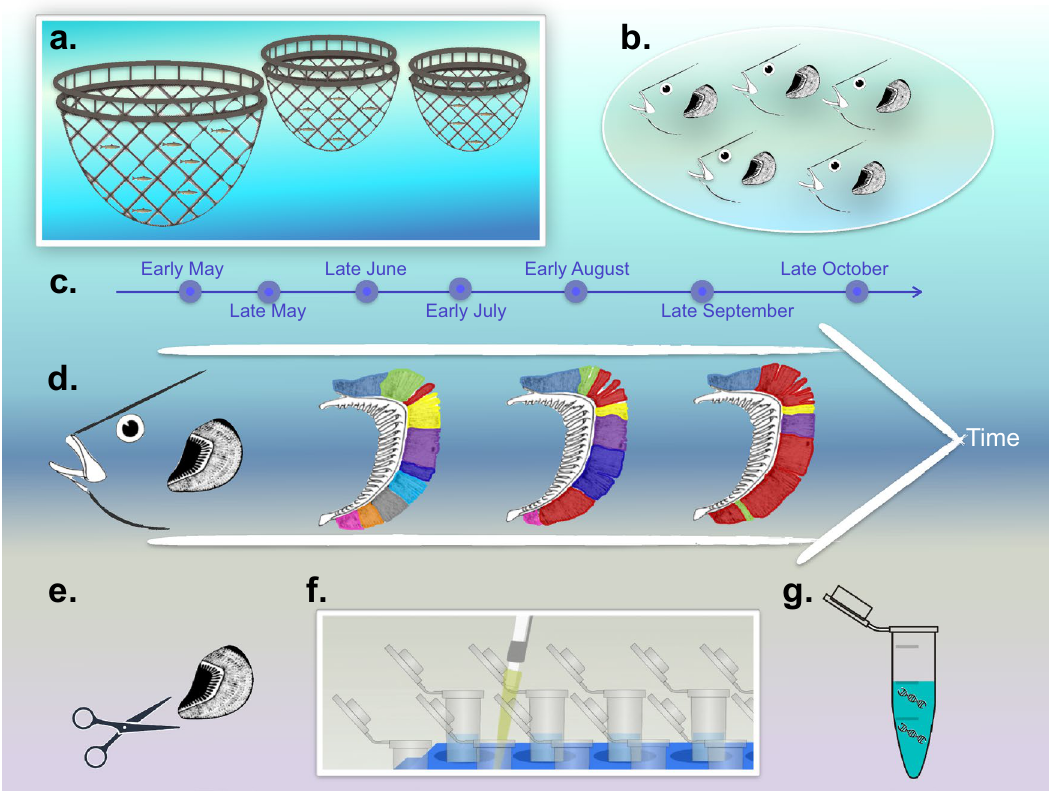
Figure 6. Overview of the sampling campaign and analytical approach. ( a ) Three cages were sampled to retrieve ( b ) five fish from each (n = 15) at each of ( c ) seven timepoints (n = 105) from May through October. ( d ) The hypothesis underpinning the study was that the amoebic gill disease (AGD) episode and concentration of N. perurans (red shading) would be associated with a shifting microbiome. The analytical approach included ( e ) sampling of gill and mucus samples, ( f ) a newly optimised DNA extraction protocol incorporating several successive washes, and ( g ) downstream analyses of nucleic acids. Figure titles with *** refer to analyses